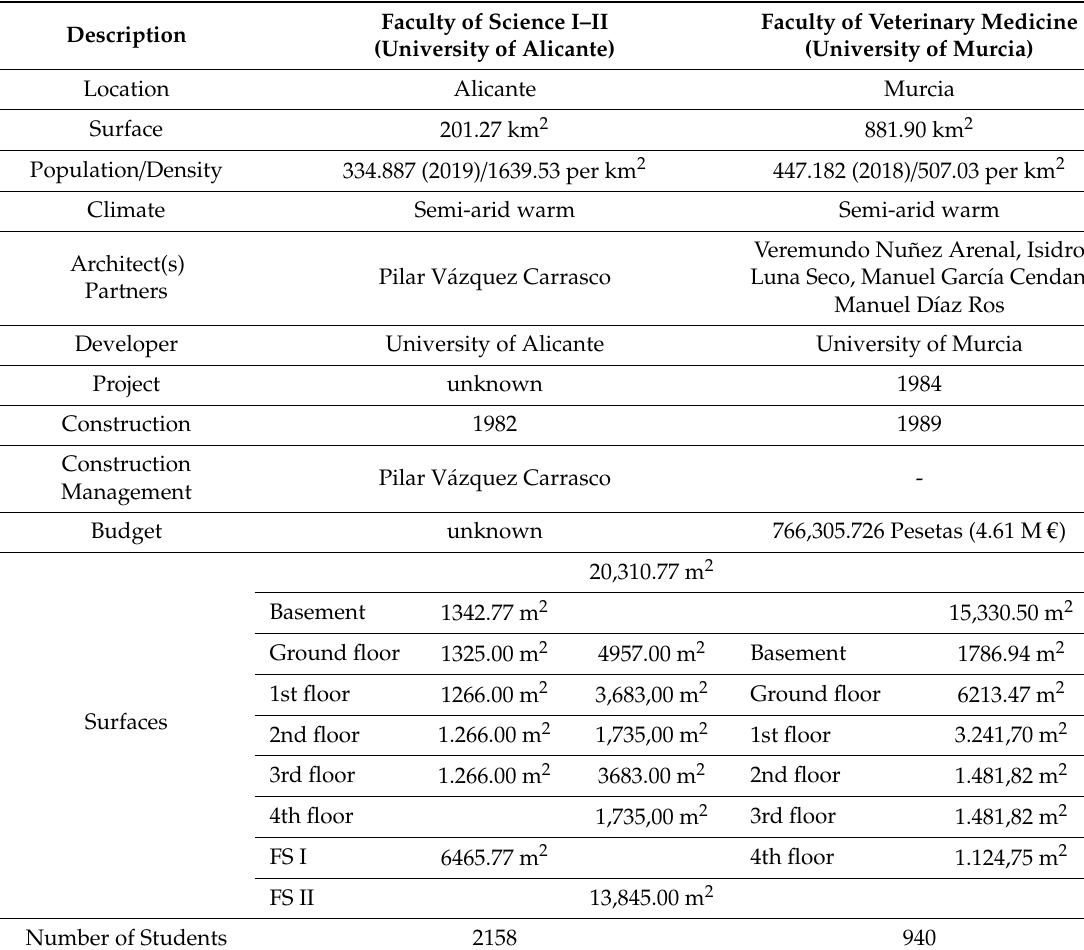
Table 1. Technical sheet for the FS of the University of Alicante and the FVM of at Murcia University.